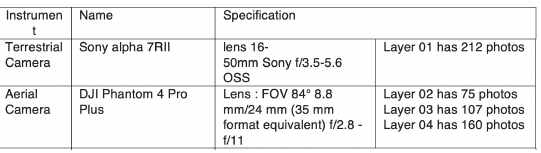
Table 1. Main properties of sensors adopted to collect photogrammetric data sets.